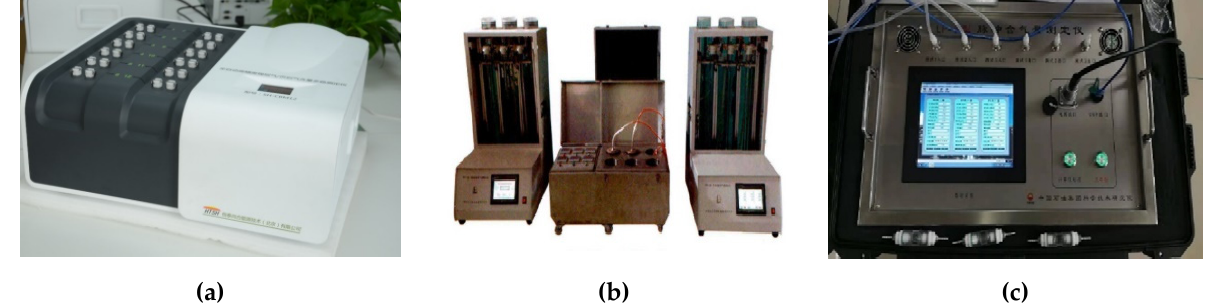
Figure 3. Three Commonly Used Desorption Devices. ( a ). High-precision flowmeter method for measuring desorbed gas; ( b ). Automatic U-shaped measuring cylinder for measuring desorbed gas; ( c ). Pulse rotation for measuring desorbed gas.